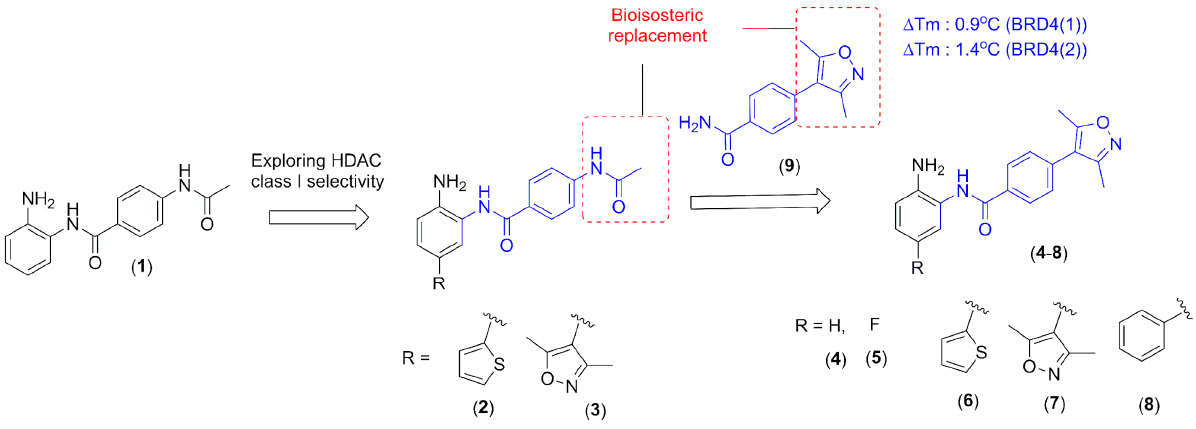
Figure 1. Drug design of the novel epigenetic modifiers.